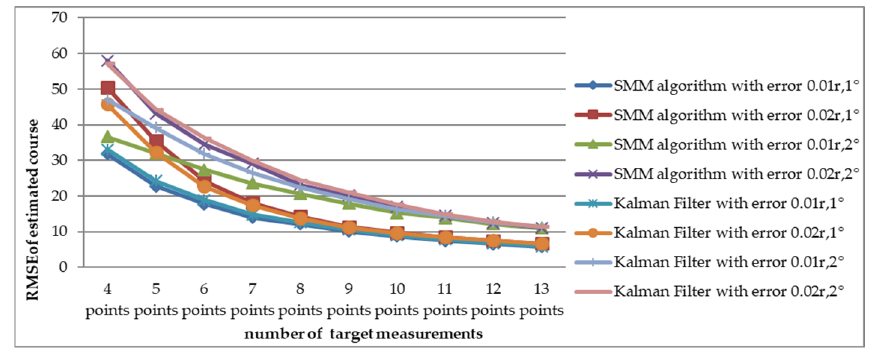
Figure 8. Comparison of estimated course RMSE between SMM algorithm and adaptive Kalman filter versus different detection error (Scenario 1).